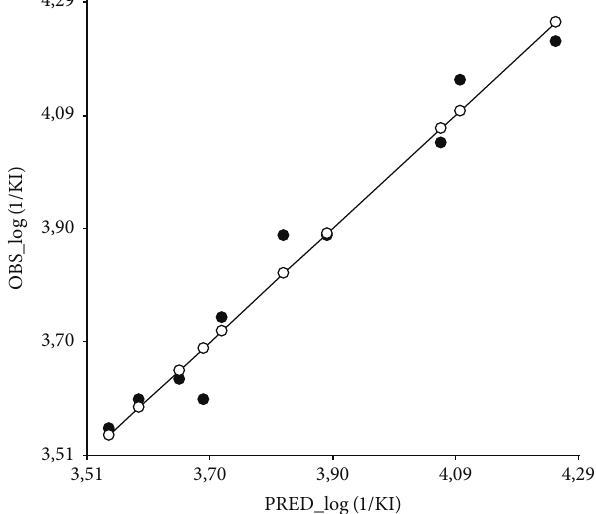
Figure 5: Multiple linear regression analysis (MLR) calculated to examine quantitative relationships between linear combinations of the dependent variable log (1/LC 50 ) and the predictor variables (structure and molecular properties). Plot of calculated versus experimental log (1/LC 50 ) of repellent activity of aldehyde and ketone compounds against cockroaches.